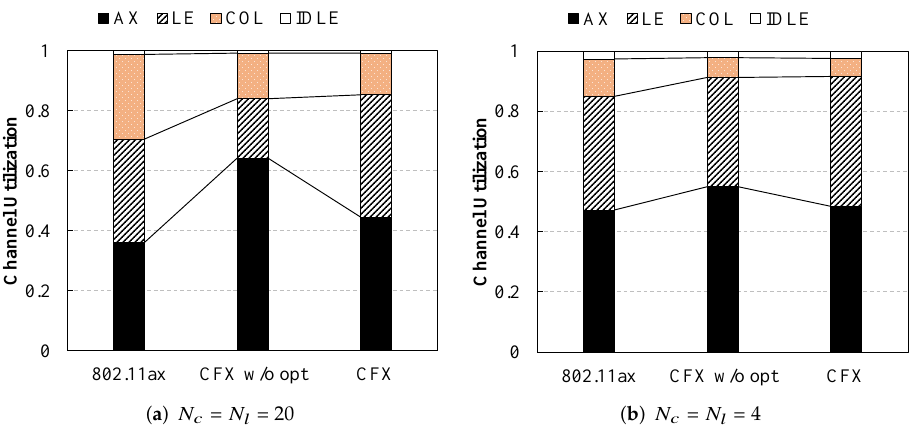
Figure 7. Channel utilization. CFX effectively reduced the probability of frame collision and thus achieved better performance for both ax and legacy users. This result is more clearly observed when the network is